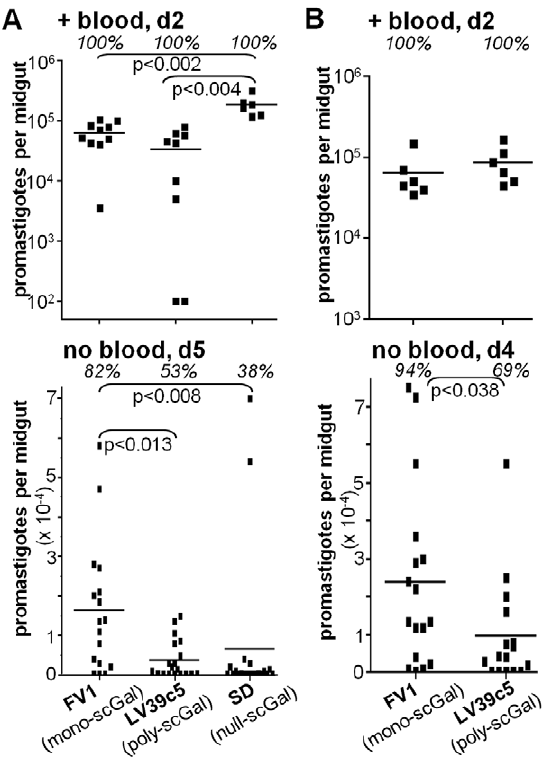
Figure 1. Galactosylated LPG does not ensure survival of L. major promastigotes in Jordan Valley strain P.papatasiPpap J sand flies. Female Ppap J sand flies were membrane fed on infective mouse blood containing the indicated L. major strain (LPG galactosyla- tion pattern in parentheses) at concentrations of 4 6 10 6 (panel A) or 8 6 10 6 (panel B) per ml. At the indicated day (‘‘d’’) after feeding, midguts were dissected and the number of viable promastigotes determined by counting under a hemocytometer. ‘‘ + blood’’ denotes midguts that retained the blood meal, and ‘‘no blood’’ denotes midguts that had no detectable blood as a result of the digested blood meal having been expelled. Each symbol represents the number of parasites in a single sand fly midgut, and each bar represents the mean number of parasites for each group. The percentages of infected flies in each group are shown in italics. P values shown were calculated for the indicated pairs of infected flies. Results from two independent experiments (panels A,B) are